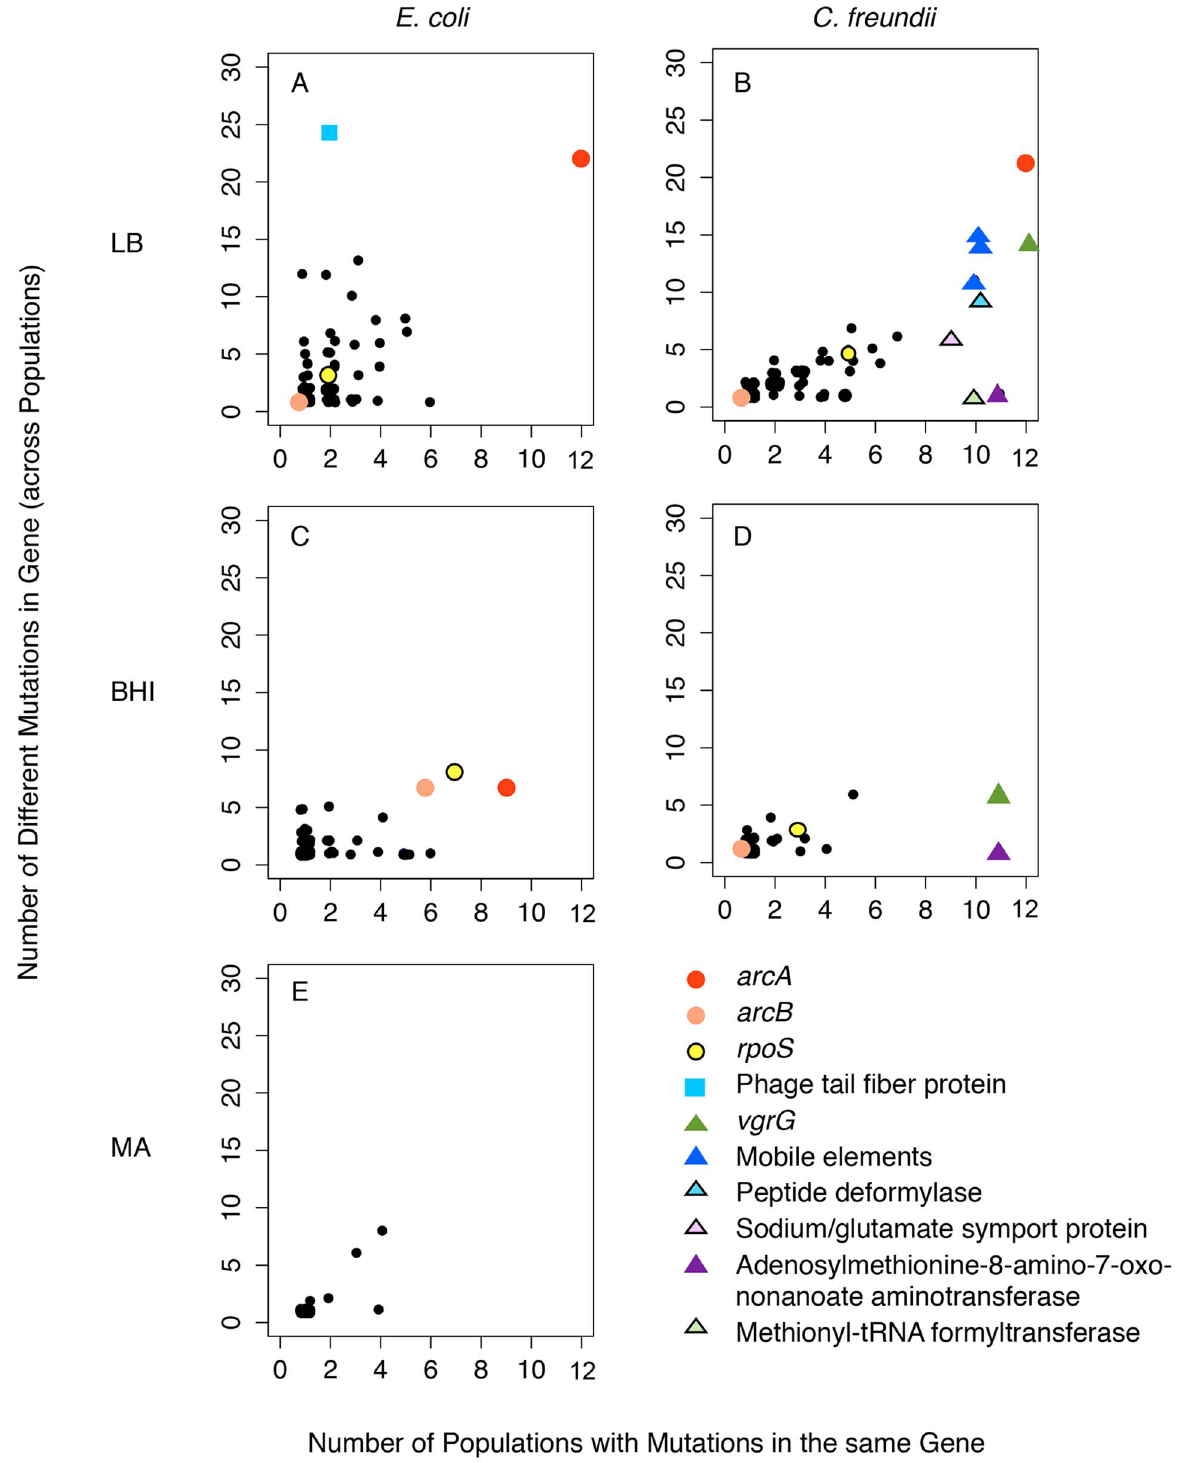
Fig. 5. Mutations in arcA and rpoS evolved repeatedly both within and among E.coli populations evolved in LB (A) and BHI (C), and C.freundii populations evolved in LB (B) and BHI (D). The number of mutations observed in the evolved populations is plotted over the number of populations with mutations in that gene. The scatterplots show all the genes with mutations for the twelve populations evolved in one environment (black circles). Selected genes that evolved in parallel are identified and marked individually, following the legend. None of these evolved genes had mutations in the mutation accumulation lines of E. coli evolved on LB agar (E).